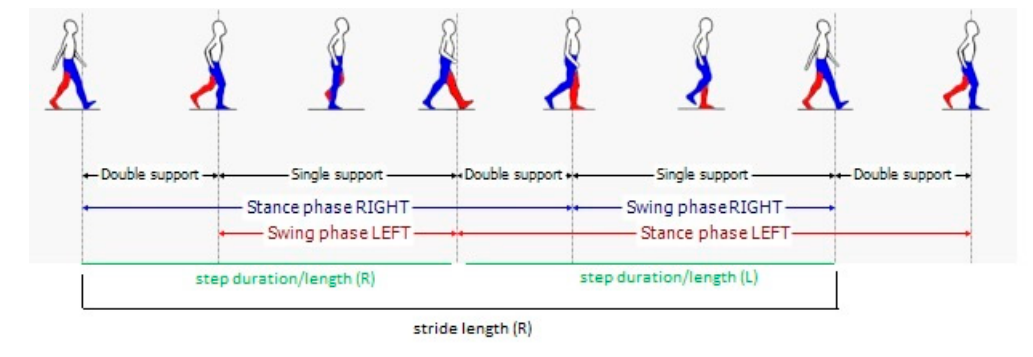
Figure 5. Gait Figure 5. Gait phases.